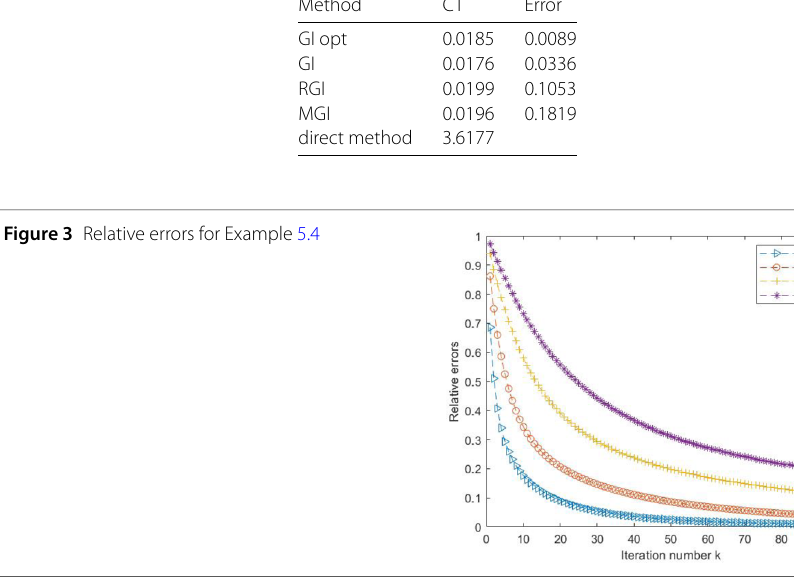
Table 4 Relative error and computational time for Example 5.4